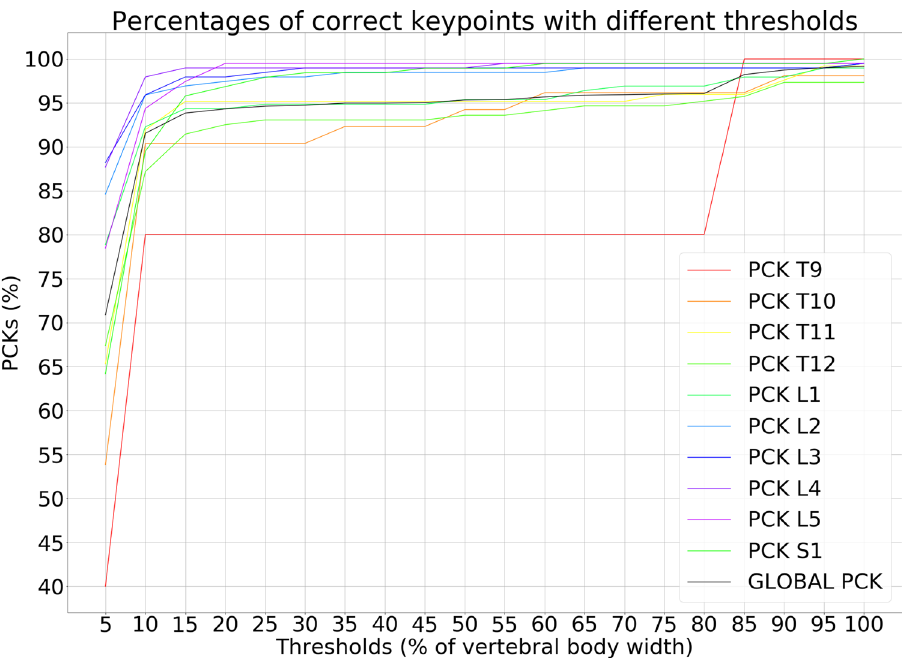
Figure 6. Curves that shows how the PCKs change according to different thresholds of the horizontal length of the